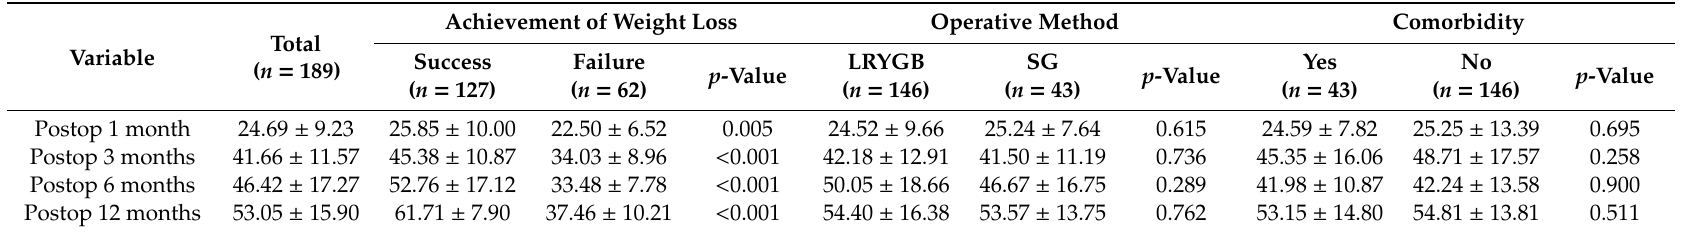
Table 2. Changes in percentage of excess weight loss (%EWL) between two groups.